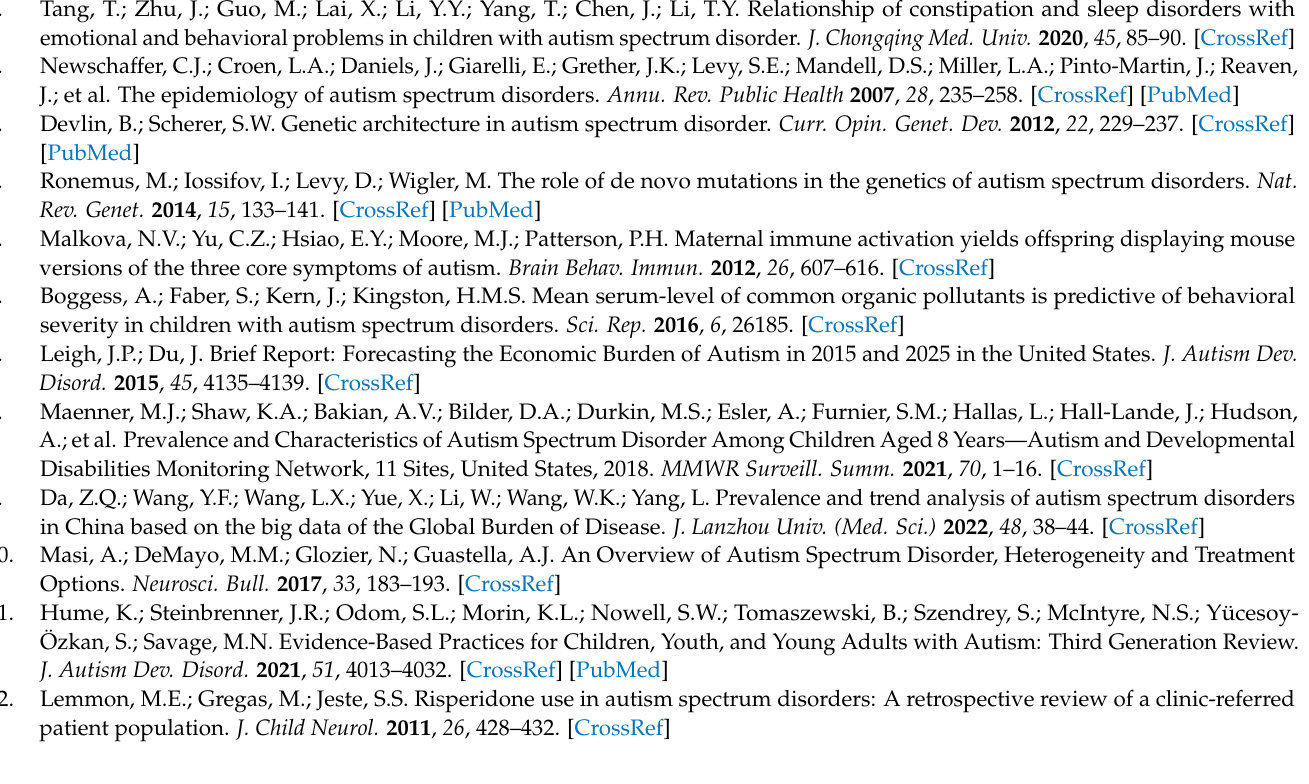
Figure S1: Forest plot for the subgroup analysis of country. Figure S2: Forest plot for the subgroup analysis of scale. Figure S3: Forest plot for the subgroup analysis of duration of intervention. Figure S4: Tests for Publication Bias. Figure S5: Test of sensitivity analysis. Figure S6: Plot of sensitivity